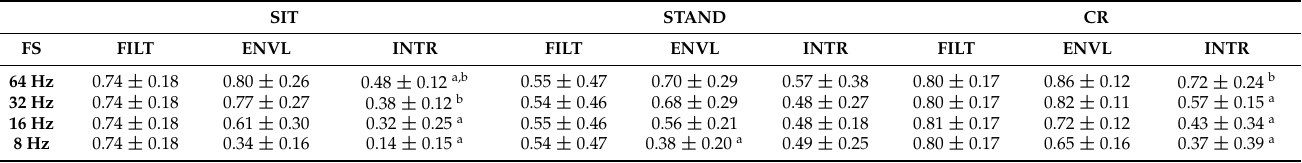
Figure 7. ( a ): average PSDs of the original PPGs (sampling frequency: 256 Hz, bandwidth: 0–64 Hz) collected from all the participants; ( b ): cumulative contribution of the different frequency components to total power ( y -axis starts at 85% to highlight differences among phases). Columns represent different protocol phases. Each participant’s PSD was computed through Welch’s periodogram after standardizing the PPG signal with z -score to reduce inter-subject variability. Table 8. Median and interquartile range of the magnitude-squared coherence between the original breathing signal and each of the three estimation methods, grouped by protocol